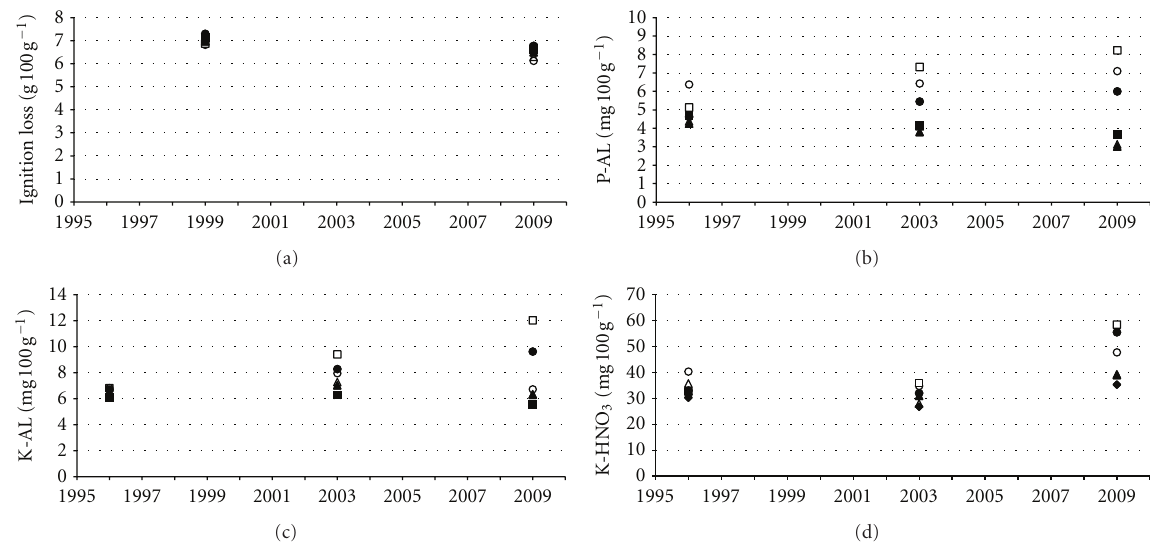
Figure 3: Topsoil (0–25cm) content of ignition loss (subplot A), P-AL (subplot B), K-AL (subplot C), and K-HNO 3 (subplot D) for the six cropping systems CA1 (conventional arable: (cid:4) ), CA2 (conventional arable, environmentally sound: (cid:2) ), OA (organic arable: (cid:3) ), CM (conventional mixed dairy: • ), OM1 (organic mixed dairy: (cid:4) ), and OM2 (organic mixed dairy with 75% clover ley: (cid:5) ). Table 7: Measured and estimated potassium flows (kgKha − 1 year − 1 ) and selected quotients (kg Kkg K − 1 ) in the cropping systems at Apelsvoll, mean 2001–2010 1